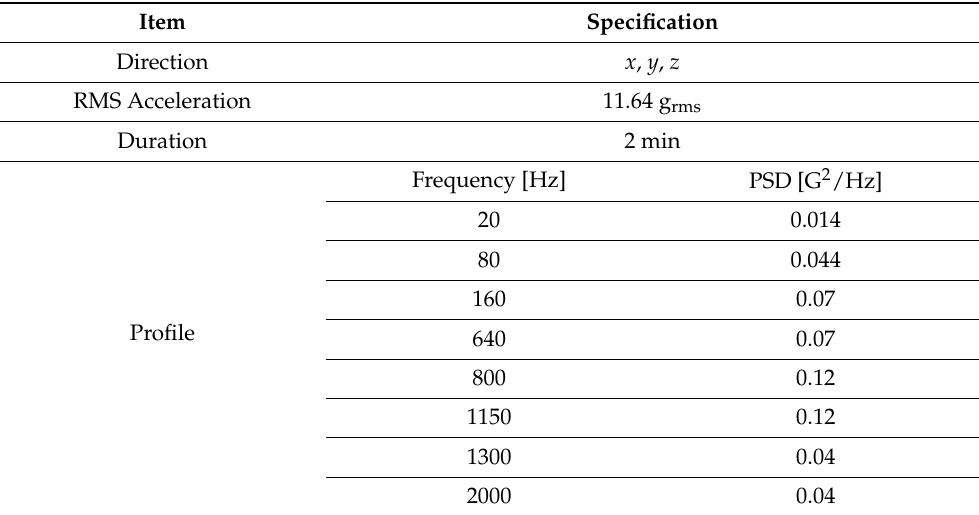
Table 5. Specification of the Random-vibration Test.